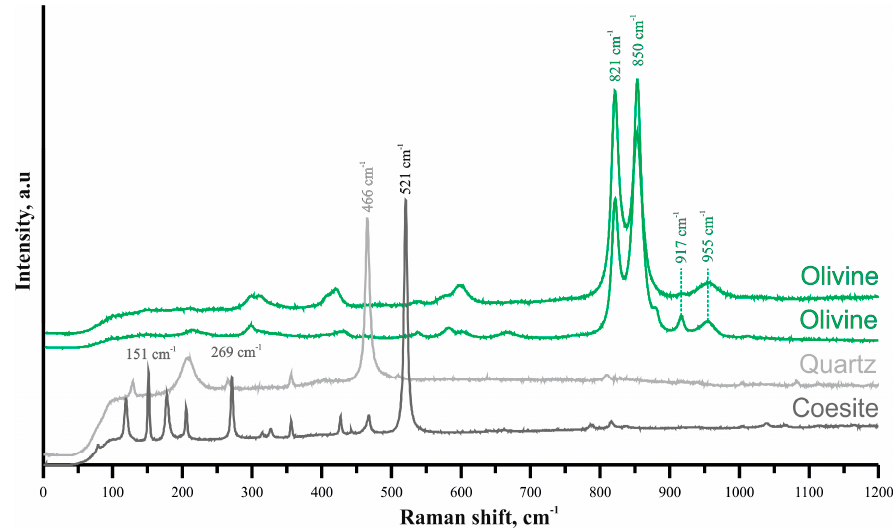
Figure 3. Representative Raman spectra of olivines, quartz and coesite from Uv-537 eclogite.